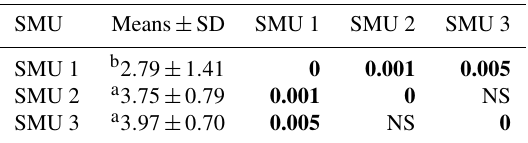
Table 2. Biocrust compressive strengths measured with a pen- etrometer; means and standard deviations (SDs) for SMUs 1–3 (kgcm − 2 ). Tests with p values (in bold) that are different from 0 with a significance level of alpha = 0.05; letters indicate significant differences.